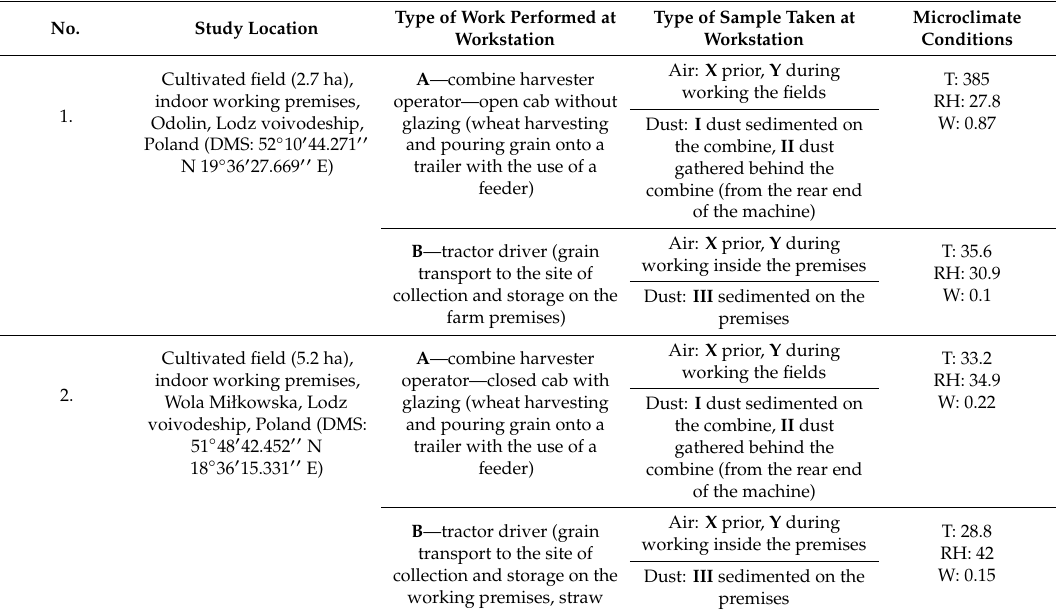
Table 3. Workplace